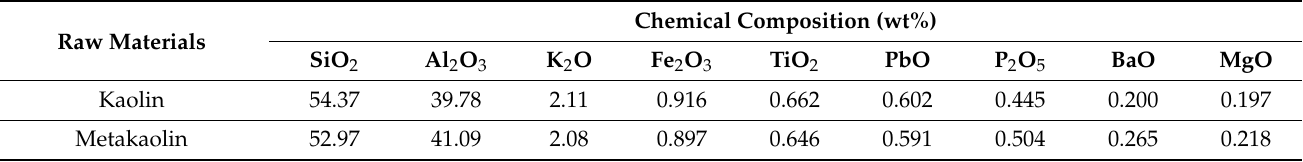
Table 1. Chemical compositions of kaolin and